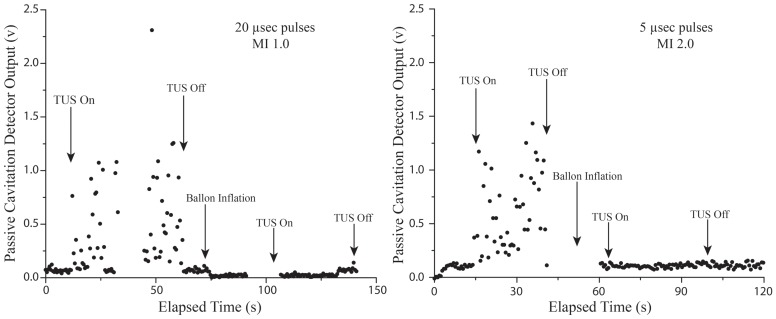
Microvascular and Angiographic Recanalization with Echo Guided Long Pulse Duration Therapeutic Impulses.The angiographic results in one of Group III pigs treated with guided long pulse duration TUS impulses. The short axis echocardiographic images delineate myocardial contrast enhancement at incremental cardiac cycles following the therapeutic impulse. The cycle number represents the number of cardiac cycles that have occurred following cessation of the TUS impulses. Although there was minimal capillary replenishment noted at 0–5 minutes into therapy, at 20–25 minutes there was more rapid restoration of contrast enhancement within the LAD risk area. Note angiographic recanalization was observed, (right lower panel), as well as improved microvascular perfusion (as indicated by the rapid replenishment of microbubbles into the risk area) at 20–25 minutes into therapy.